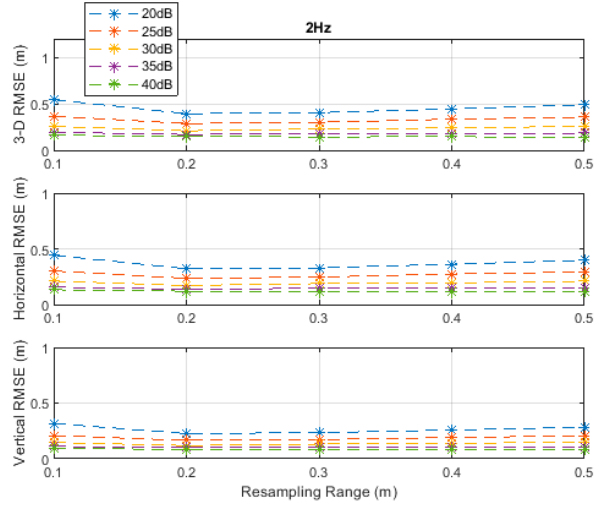
Figure 3. RMSE results along the 3D linear path at a measurement update rate of 2 Hz.